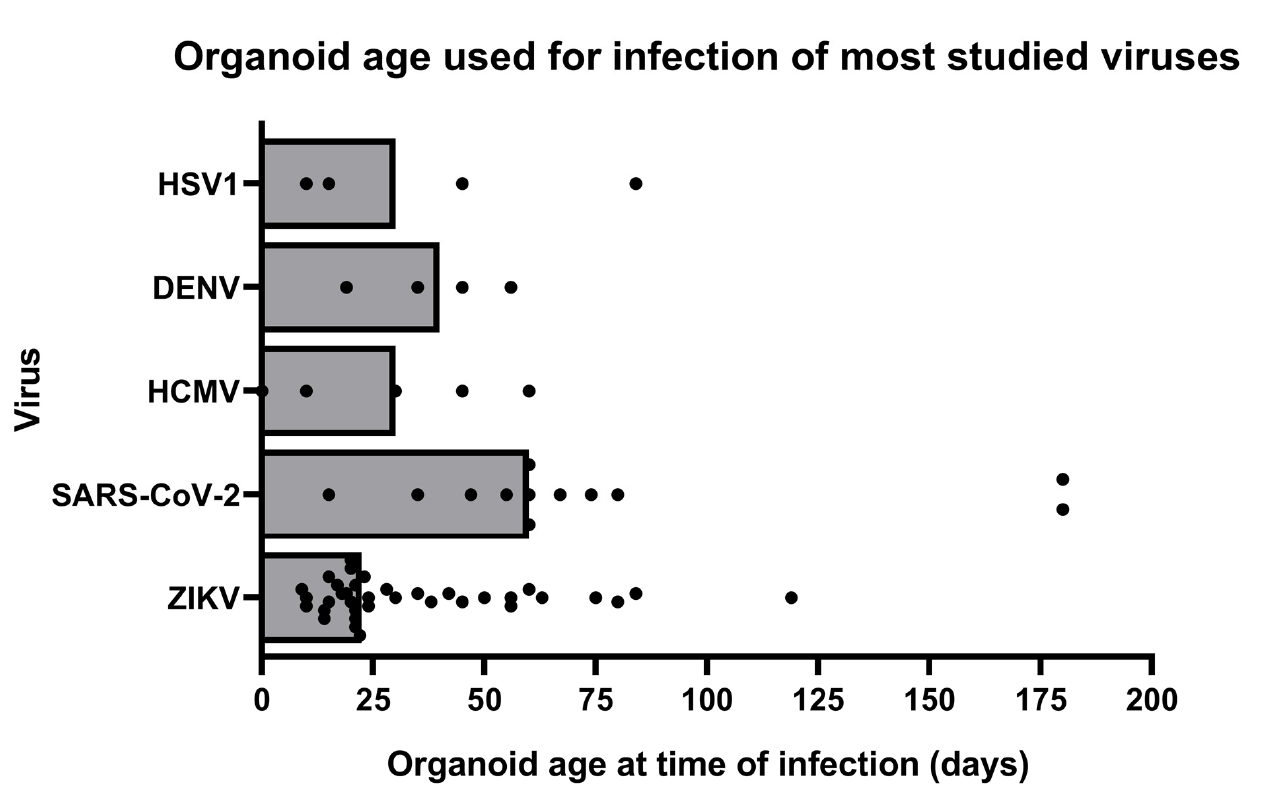
Figure 3. Brain organoid age, at time of infection, in studies on infection of HCMV, HSV1, SARS-CoV-2, and ZIKV (in days). Bars represent median organoid age, and each dot is a single study on the respective virus. Table 1. Research topics on brain organoid viral infection, depicted as percentage of studies that have reported on these different research subjects.